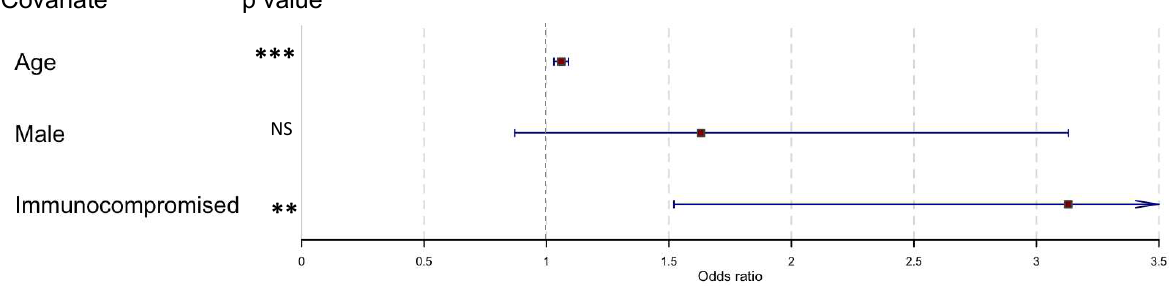
Figure 1. Forest plots of mixed-model logistic regression analysis ( A ). comparing severity of COVID- 19 symptoms between hospitalized adult patients infected with Delta ( n = 166) and Omicron ( n = 905) (excluding patients with untyped VOC, n = 210) and ( B ). identifying risk factors for in-hospital mortal- ity related to COVID-19 in adult patients infected with Omicron and moderate/severe/critical/fatal COVID-19 ( n = 323) (i.e., excluding patients with asymptomatic/mild symptoms). Covariates: Omi- cron versus Delta; age odds increase per year; male versus female; immunocompromised versus non-immunocompromised; unvaccinated versus any vaccination; vaccinated <2 months before admission versus unvaccinated or vaccinated >2 months before admission. Abbreviations: NS, non-significant; * p < 0.05; ** p < 0.01; *** p < 0.001.